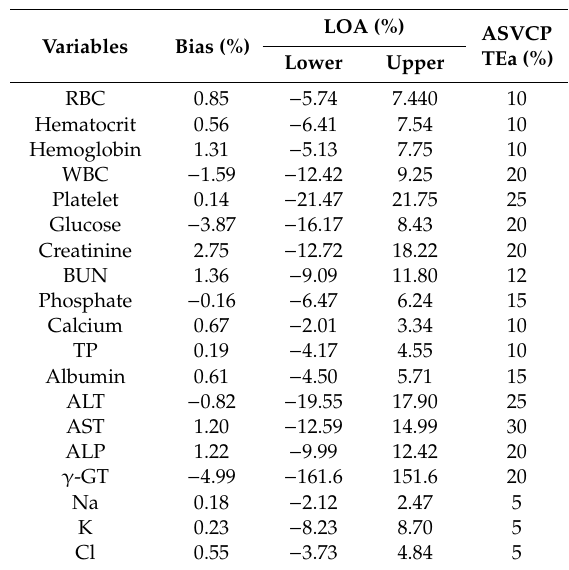
Figure 1. Bland–Altman plots of hematological parameters comparing arterial and venous blood samples. The percentage difference of venous and arterial results is plotted against the mean of the venous and arterial results. Gray shading indicates the area exceeding the allowable total error (TEa). If the upper and lower lines of the LOA are not within the gray shading, it indicates clinical interchangeability between the venous and arterial results. RBC, red blood cell; Hct, hematocrit; Hb, hemoglobin; WBC, white blood cell; LOA, limit of agreement. Table 3. Bias and limit of agreement (LOA) of Bland–Altman analysis and recommended allowable total error